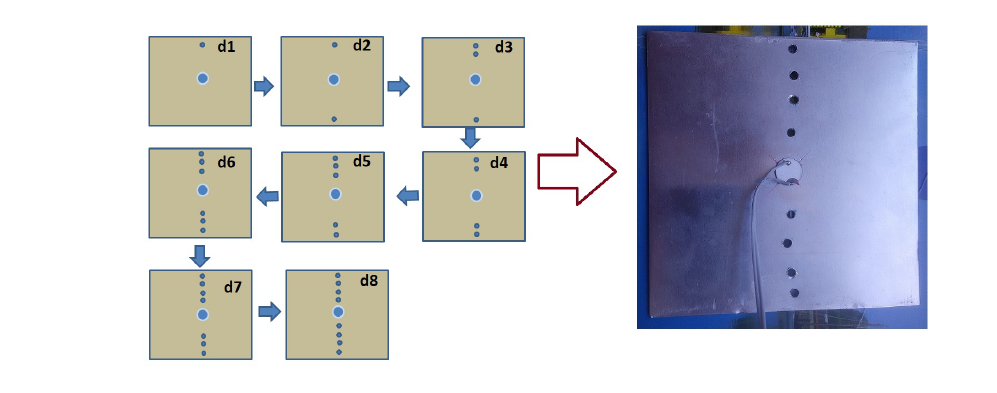
Figure 2. The sequences of holes creation and the created hole on Al square